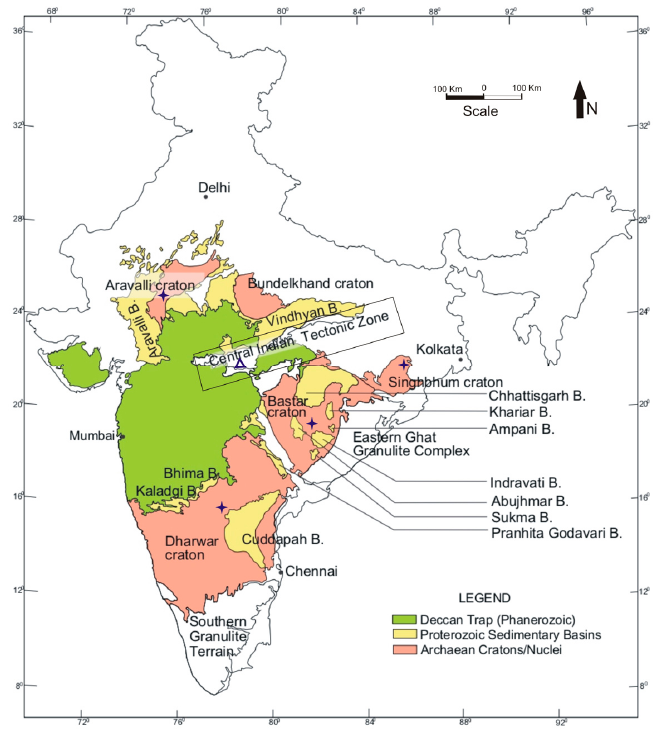
Figure 1. Simplified geological map of India showing position of five cratonic blocks and sedimentary basins (after Mazumder et al., 2019a [21]) with reported IOCG deposits (blue stars) and study area in (triangle).